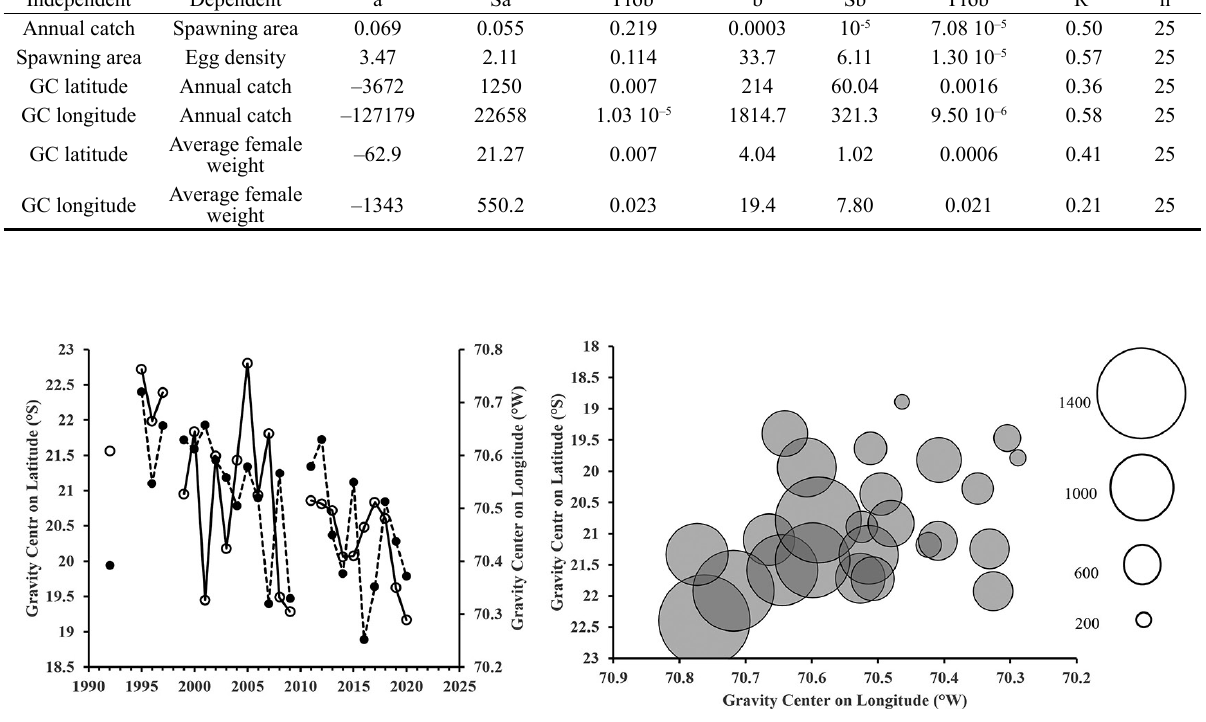
Fig. 4. – A, centre of gravity of egg distribution. B, centre of gravity of egg distribution and annual catch (diameter of the